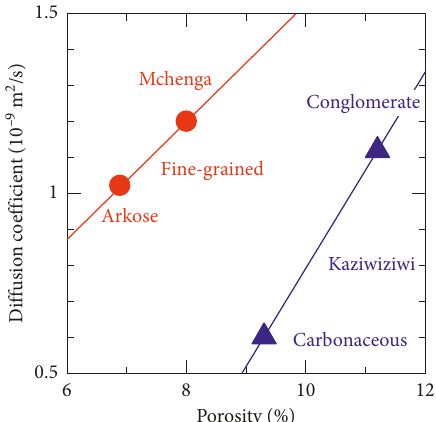
Figure 15: Dependence of water vapor diffusion coefficients of Malawi rocks on